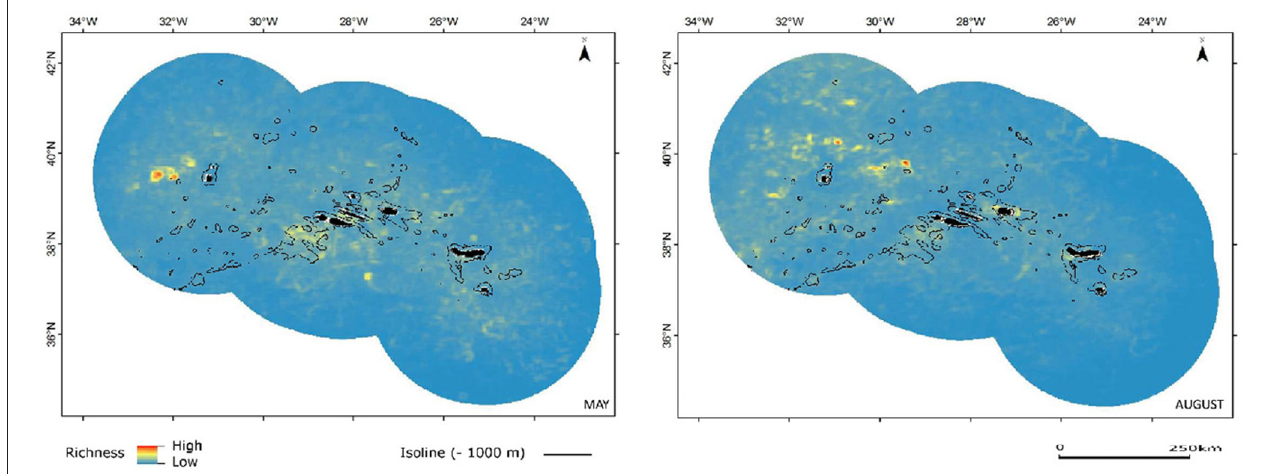
FIGURE 3 | Combined predicted cetacean richness in spring (May) and summer (August). Color shading indicates relative species richness, with warmer colors corresponding to increased